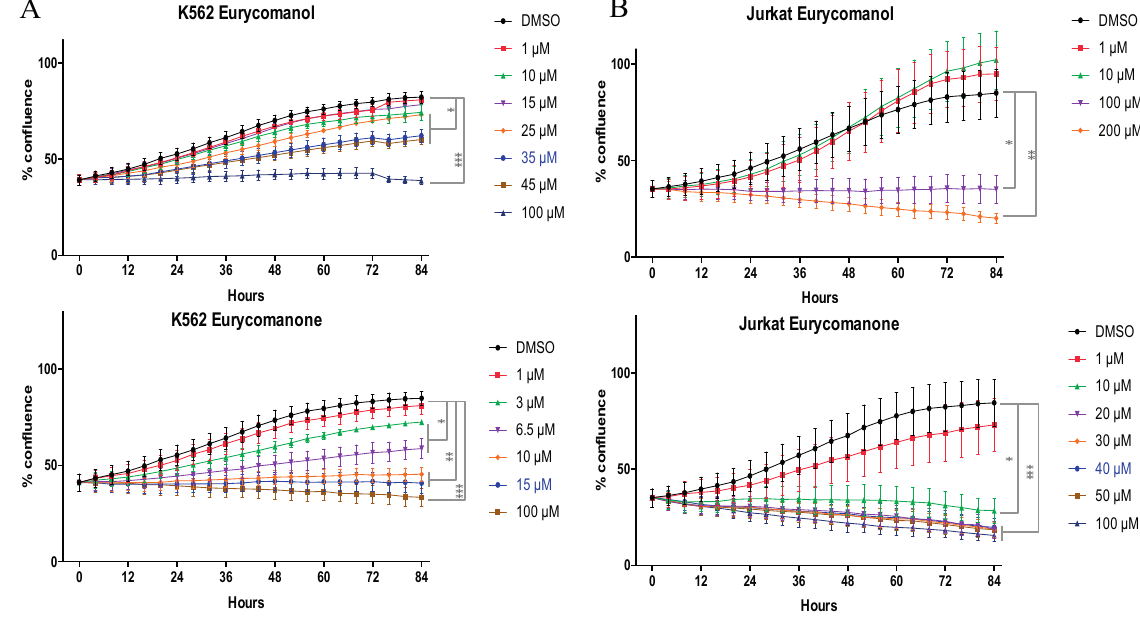
Figure 3. The effect of eurycomanone and eurycomanol on K562 ( A ) and Jurkat ( B ) cell proliferation. Cell proliferation was evaluated by using the IncuCyte TM Life-Cell Imaging System. DMSO corresponds to solvent-treated control. Each value is the mean ± SEM of three independent experiments. The asterisk indicates a significant difference compared to the negative control analyzed by the t -test (* p < 0.05, ** p < 0.01, *** p <